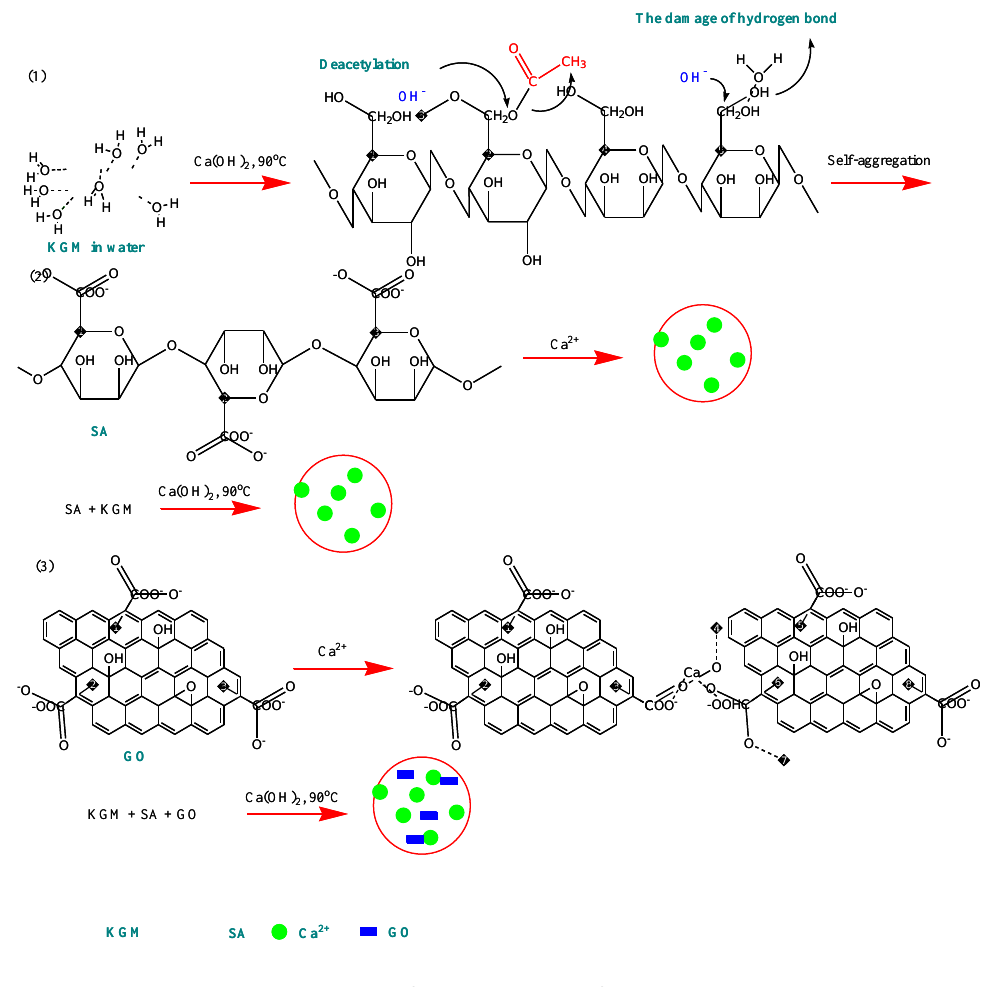
Figure 4. The possible mechanism of the gelation of KGM, KGM/SA and KGM/SA/GO hydrogels. Reprinted wih permission by Elsevier